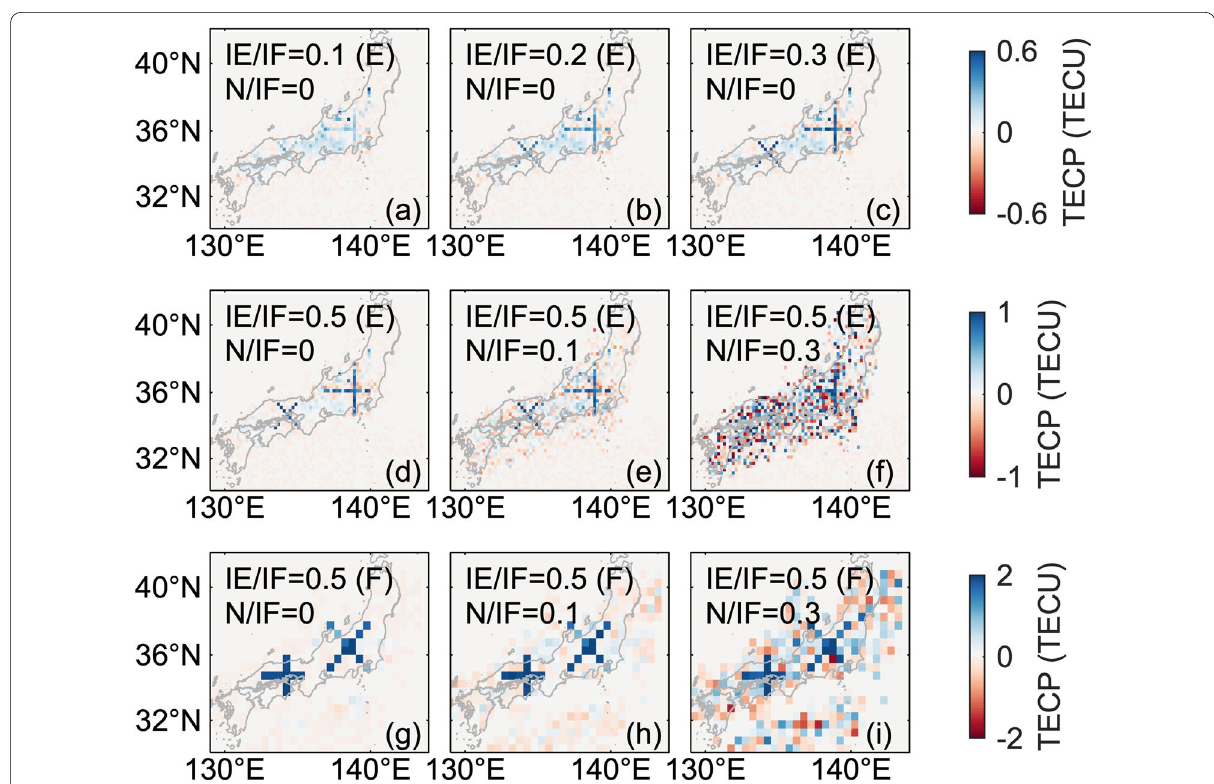
Fig. 5 2-D maps of output irregularities at different ratios of input amplitude in E and F regions (IE/IF) ( a – c ), and different ratios of noise standard deviation to input amplitude in F region (N/IF) ( d – i